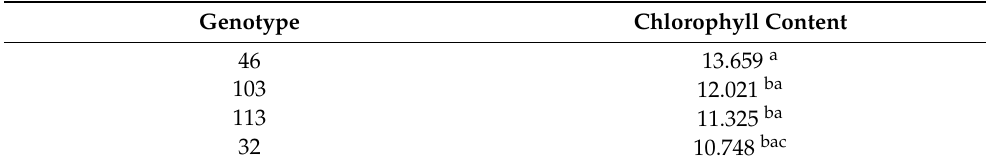
Table 2. The highest chlorophyll content (Chla + b) at a 135 mM salt concentration using the Duncan test.